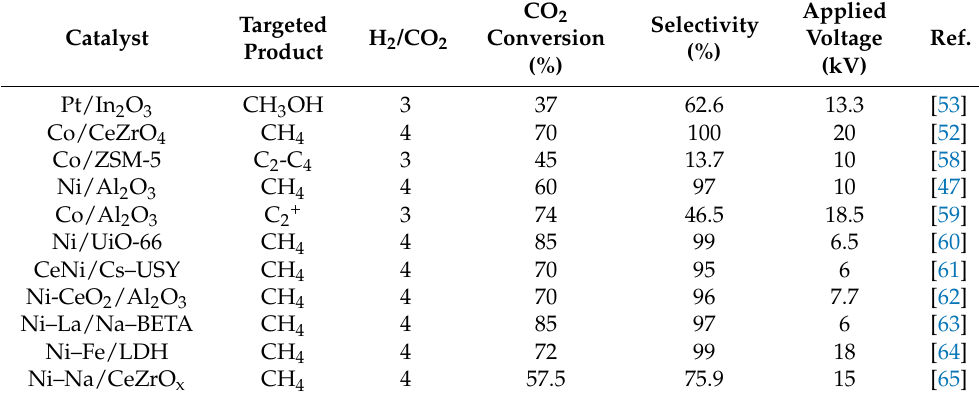
Table 1. Catalytic CO 2 hydrogenation assisted with DBD